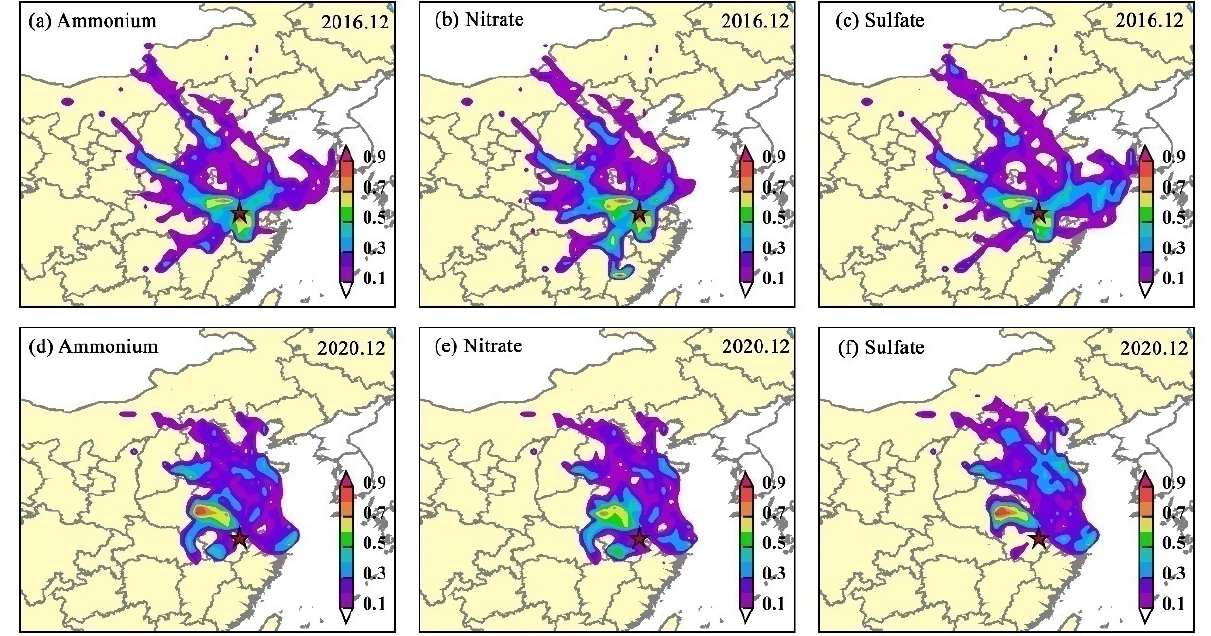
Figure 9. Source areas for ammonium, nitrate and sulfate between December 2016 and 2020 in Nanjing. ( a ) ammonium, ( b ) nitrate, ( c ) sulfate in December 2016; ( d ) ammonium, ( e ) nitrate, ( f ) sulfate in December